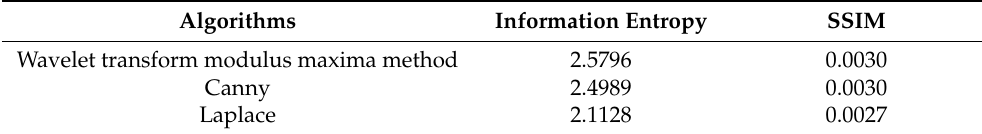
Table 2. Information entropy and SSIM for the three algorithms.